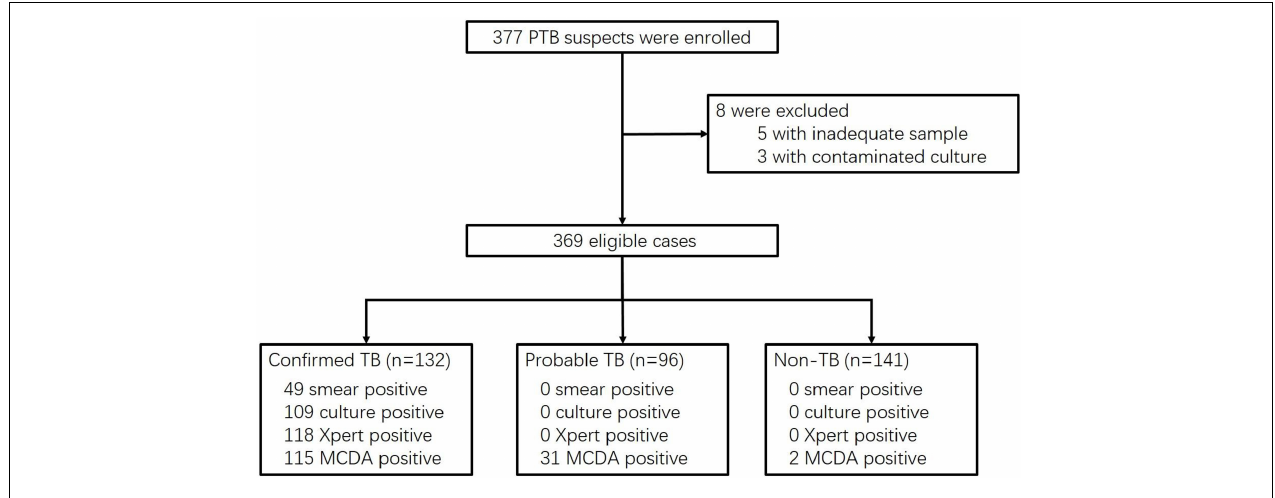
FIGURE 1 | Flow chart of participant recruitment.